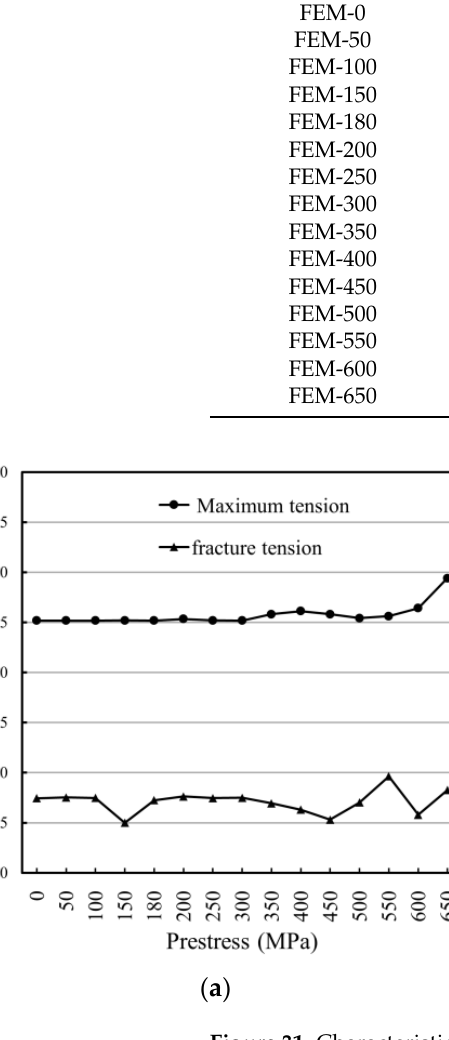
Figure 31. Characteristic parameter variation curve of coupler overload protection. Table 9. The failure parameters of VCSB connection structure under tensile load with the prestress from 0 to 650 MPa.